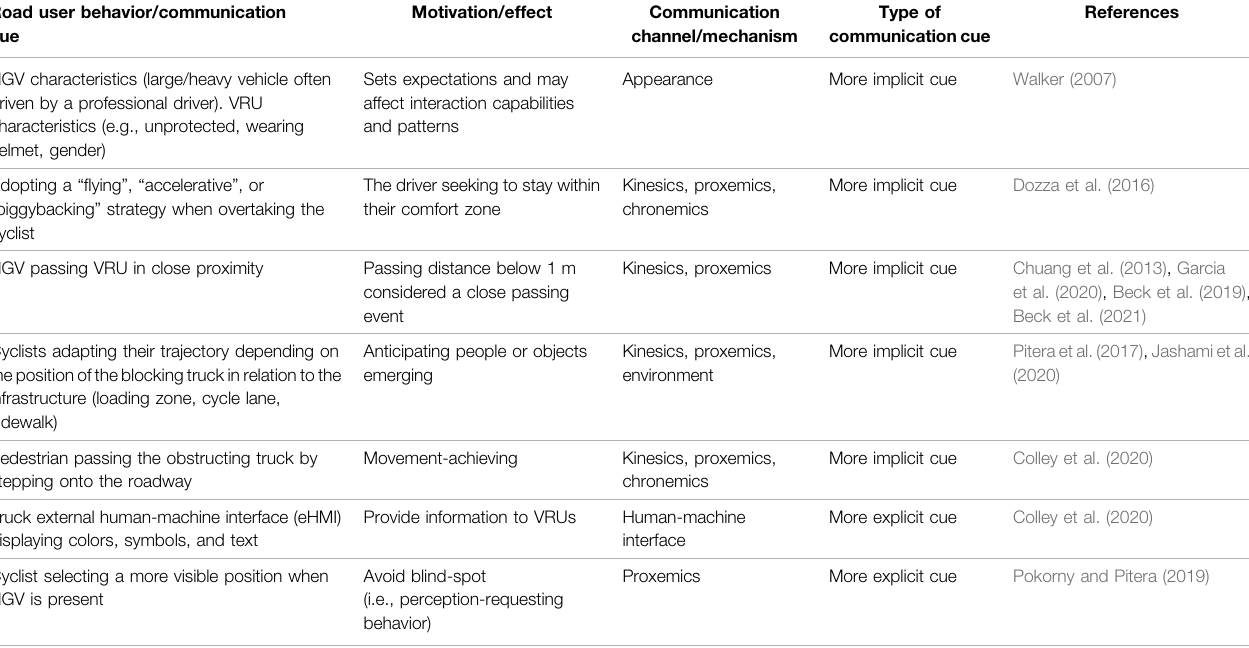
TABLE 3 | Reported interactive road user behaviors/communication cues from HGV-VRU obstructed path scenarios, including their motivation/effect, communication channel/mechanism, type of cue, and